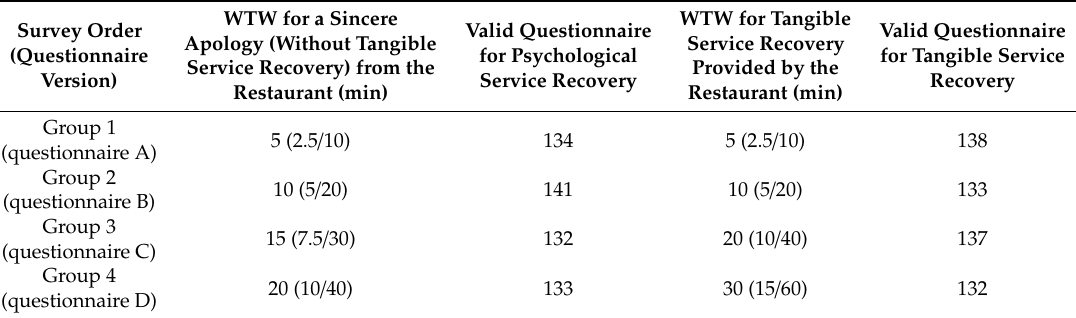
Table 1. Bid values for the double-bounded dichotomous choice